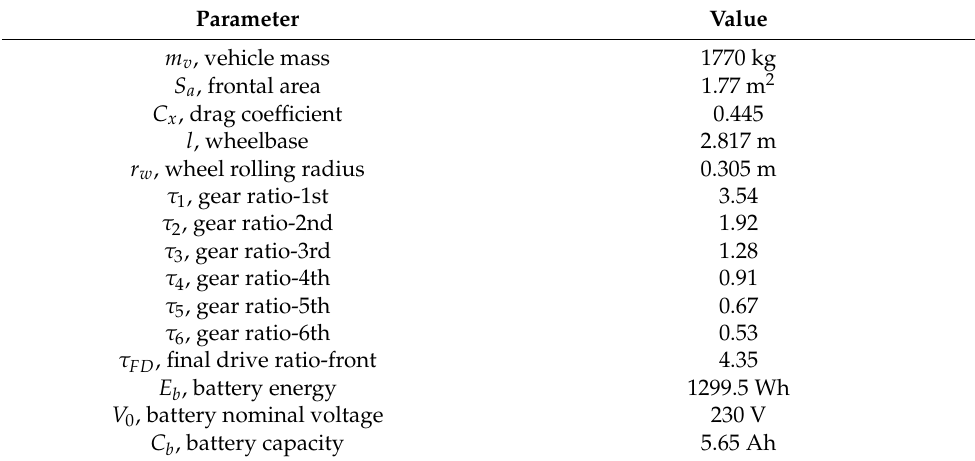
Table 2. HEV geometry and transmission main parameters.